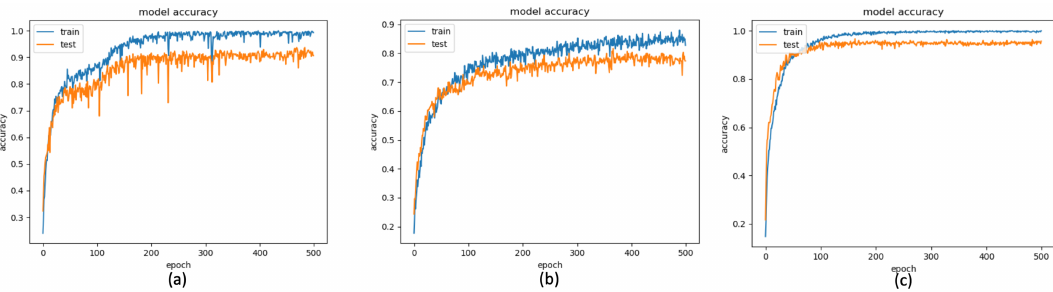
Figure 13. LSTM Accuracy of the depth-sensor only result ( a ) depth camera, ( b ) gyro sensor, and ( c ) accelerometer.